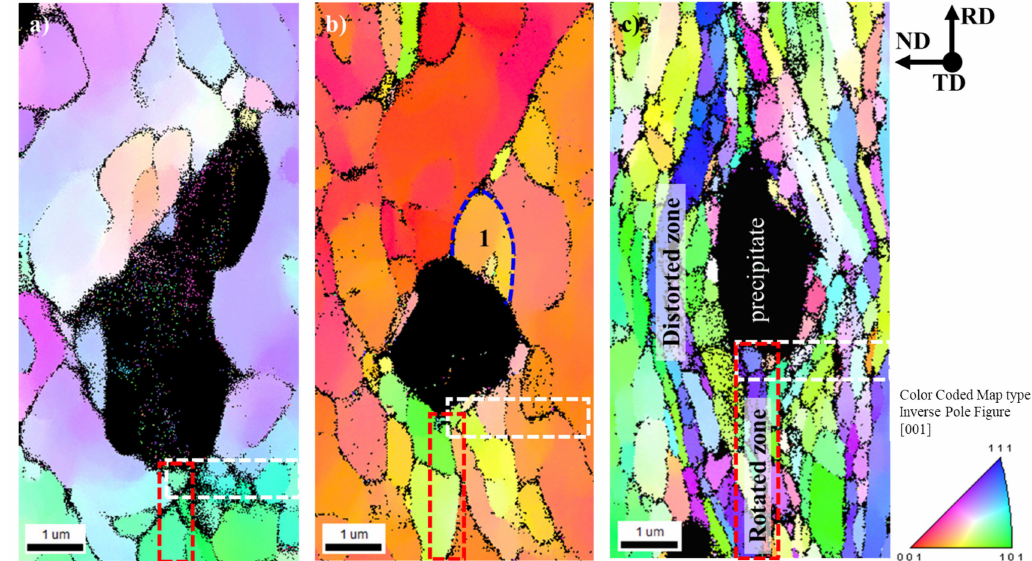
Figure 4. EBSD map around the α -Al(Mn, Fe)Si precipitate in the longitudinal section of the cold-rolled AA3003 aluminum alloy with different amounts of reduction, ( a ) 20%, ( b ) 50%, and ( c ) 90%. The inverse pole figures (IPF) indicate the color key of the crystal direction parallel to the normal direction